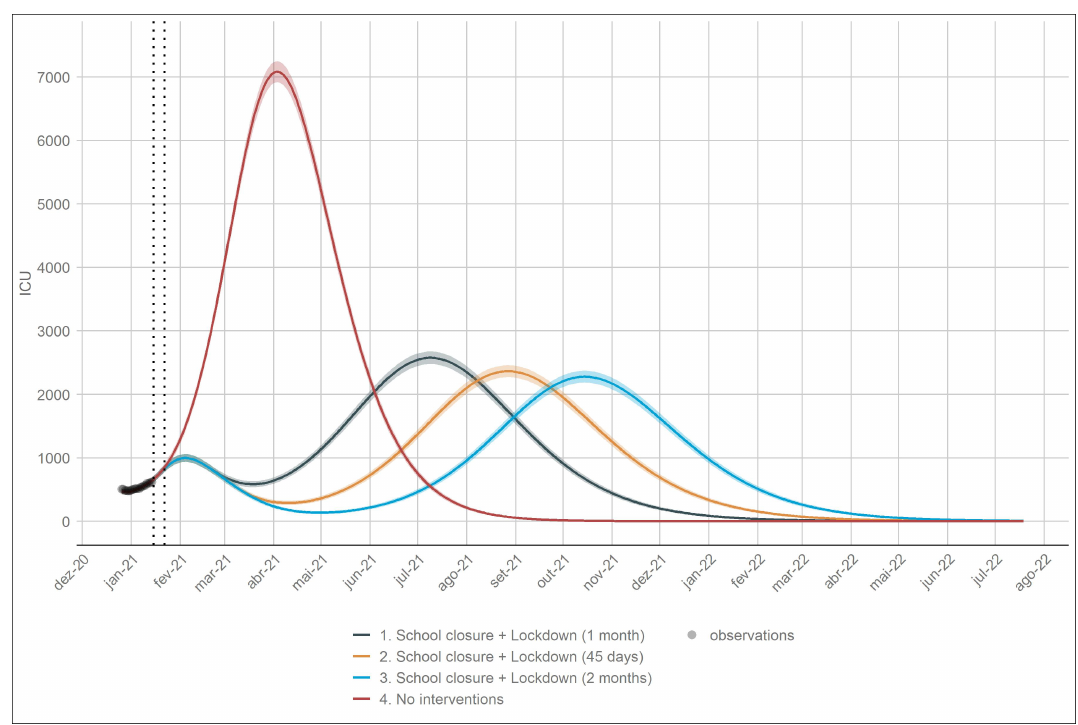
Figure 5. School closure and lockdown simulations on the number of ICU cases. The dotted vertical lines depict the imple- mentation of the lockdown and the closure of schools. The simulation in red represents the scenario with no